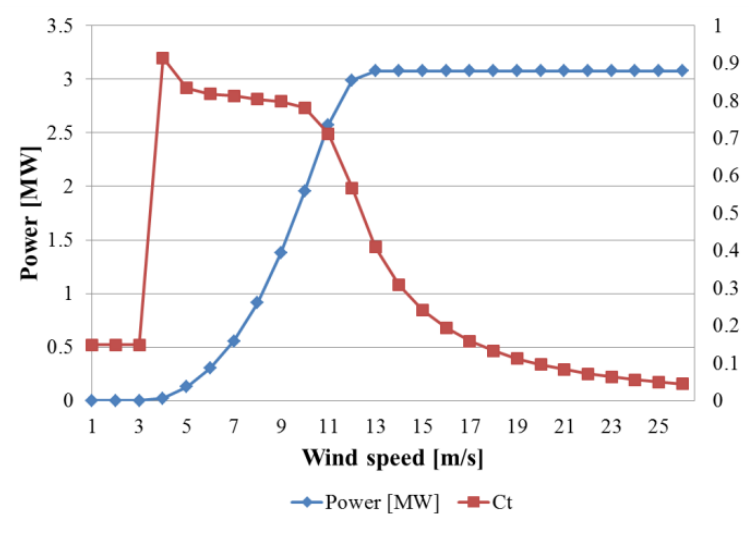
Figure 3. Power curve and thrust coefficient curve of the wind turbine used in this